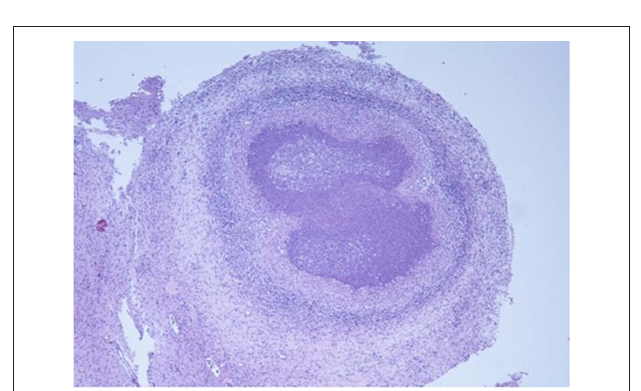
Figure 2 | Hematoxylin and eosin staining.